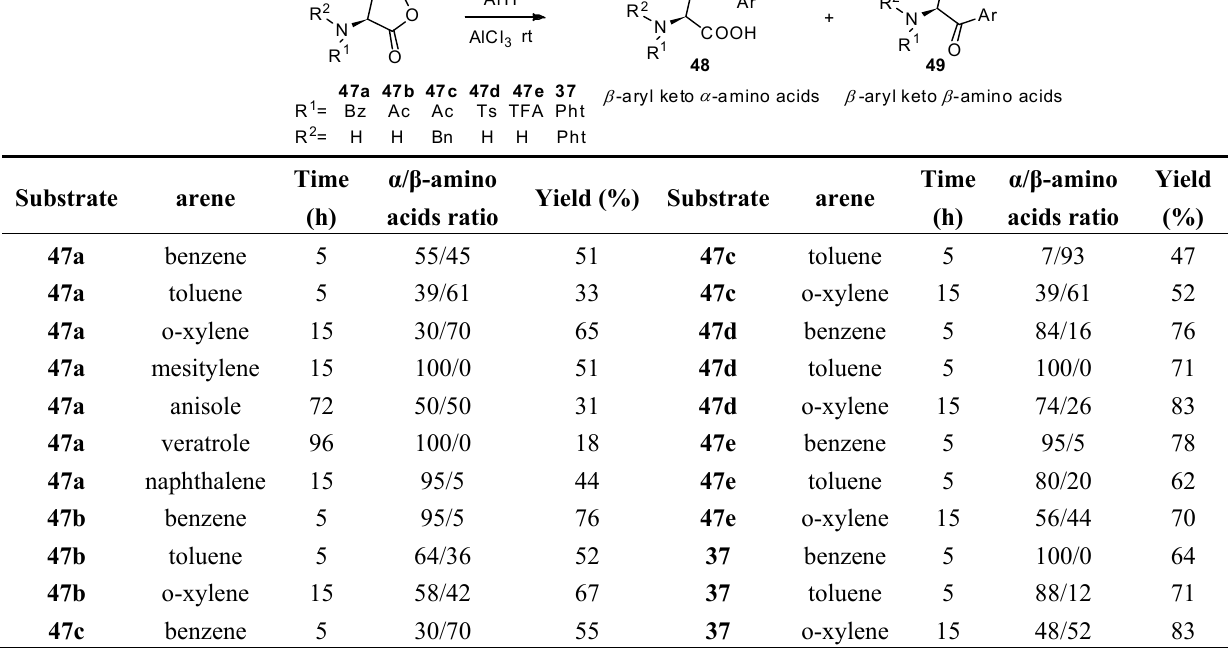
Table 1. Regioselectivity of anhydrides in Friedel-Crafts